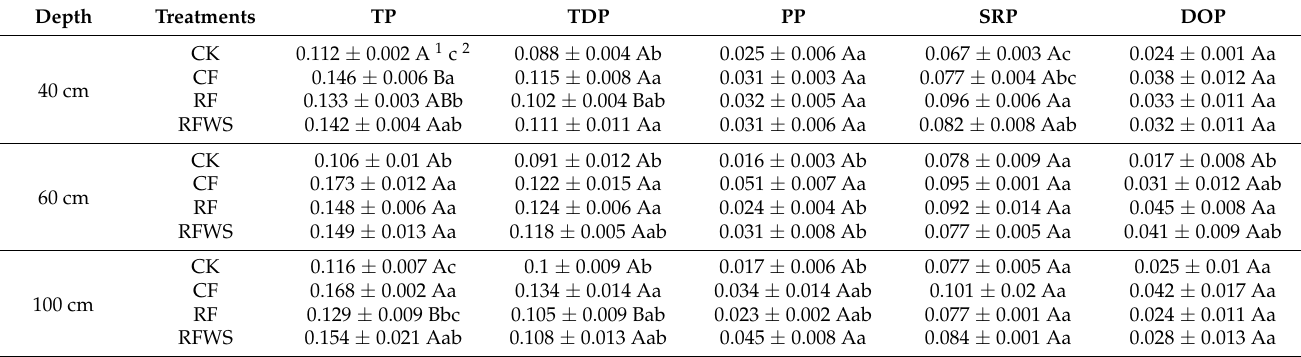
Table 4. P concentration of different treatments at different depths (mg L − 1